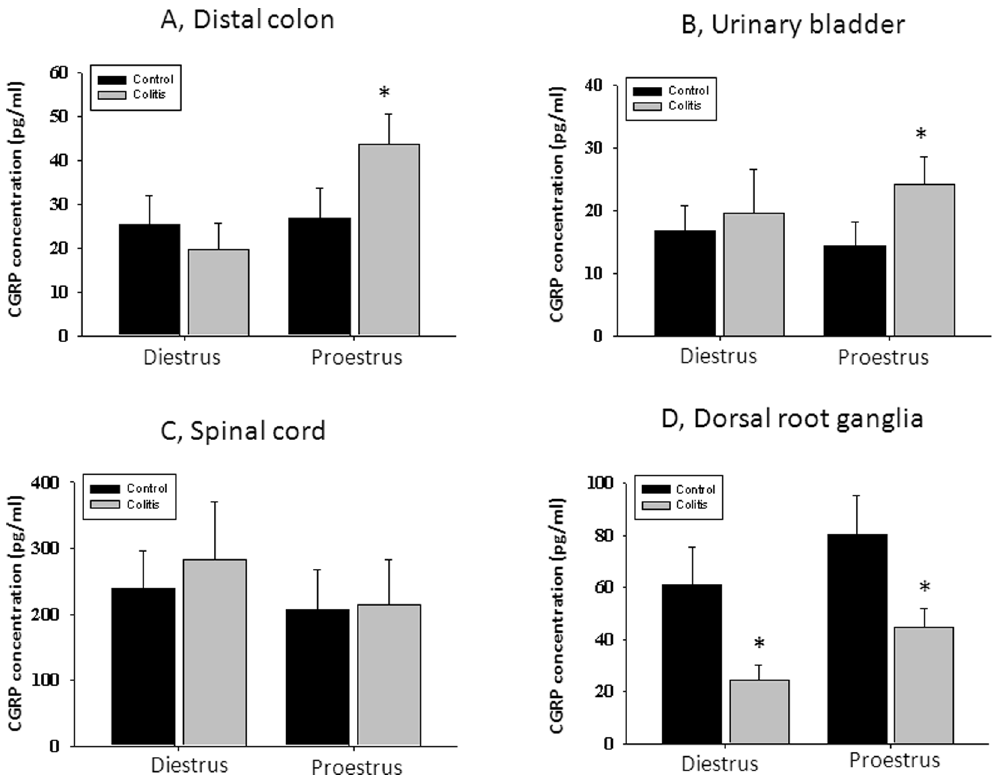
Figure 2. Estrous cycle dependent changes in CGRP content in the pelvic viscera and neural tissues after experimentally induced colitis. A, CGRP content in the distal colon during low (diestrus) and high (proestrus) estrogen. B, Concentration of CGRP in the urinary bladder during diestrus and proestrus phases. C, Neither phase of the estrous cycle nor colonic treatment significantly modulated CGRP content in the lumbosacral spinal cord. D, CGRP fluctuations within the estrous cycle in L6-S2 sensory ganglia innervating the pelvic organs. * - p # 0.05 to respective control group.